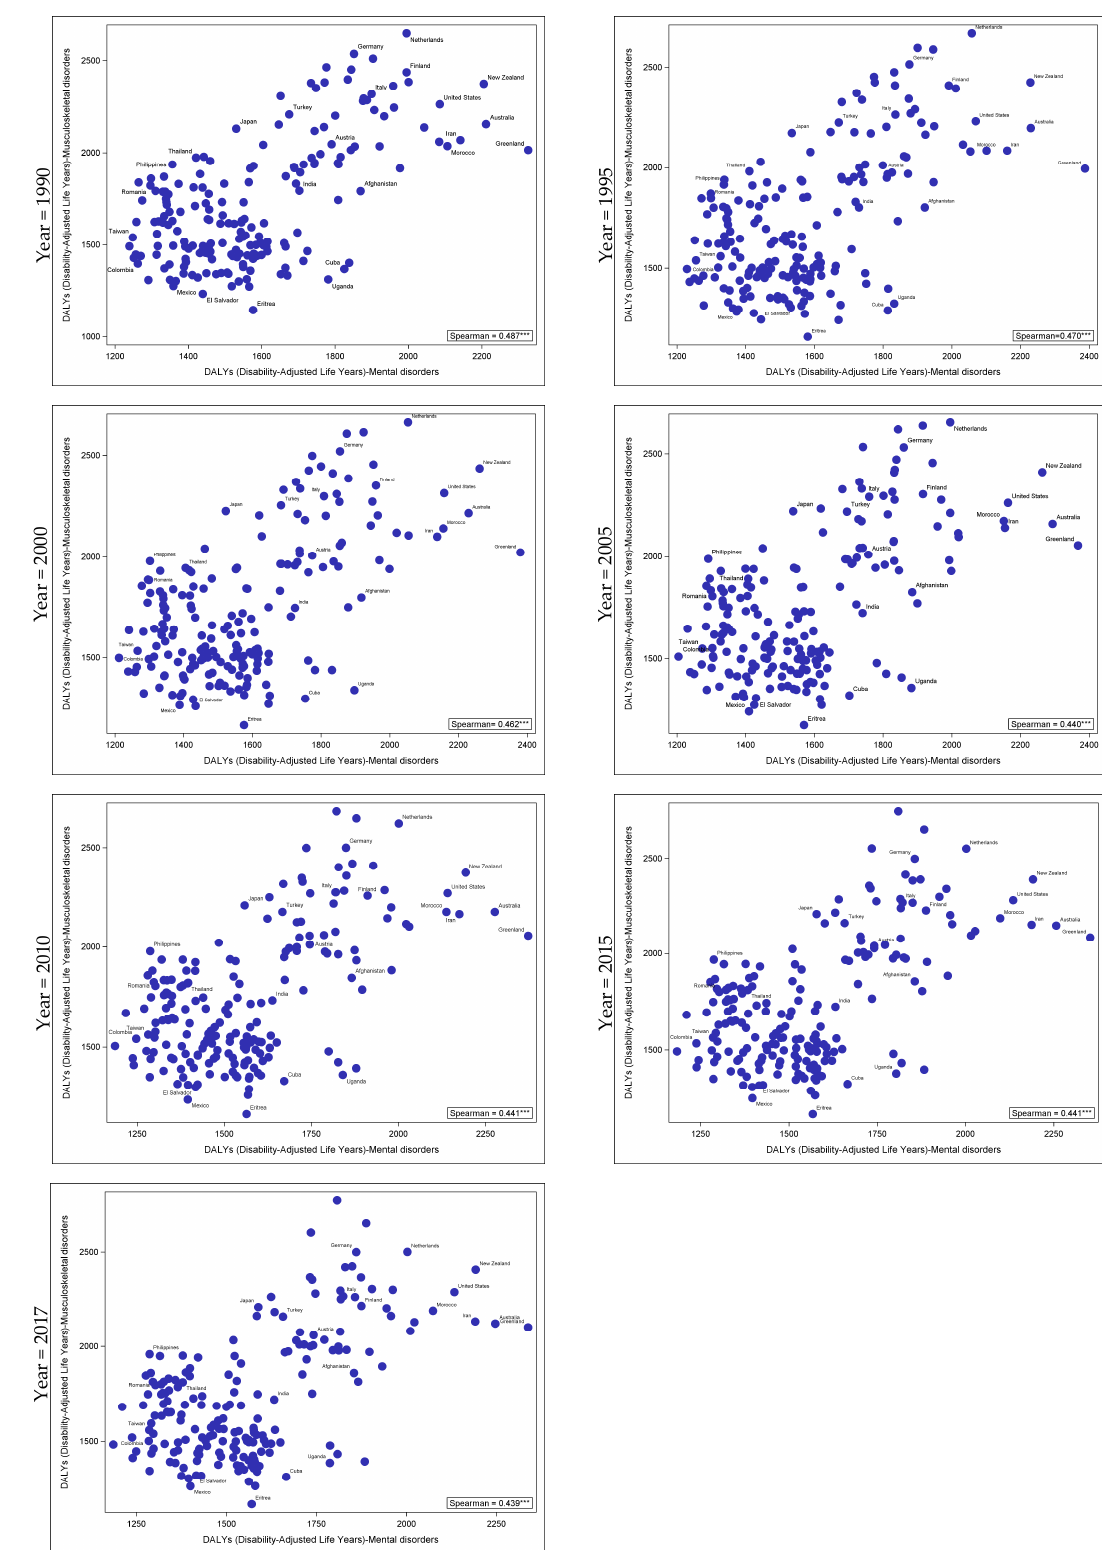
Figure 2. Correlation between age-standardized musculoskeletal and total mental disorders (MDT) DALYs among 195 countries, for both sexes, between 1990 and 2017. *** p < 0.0001.